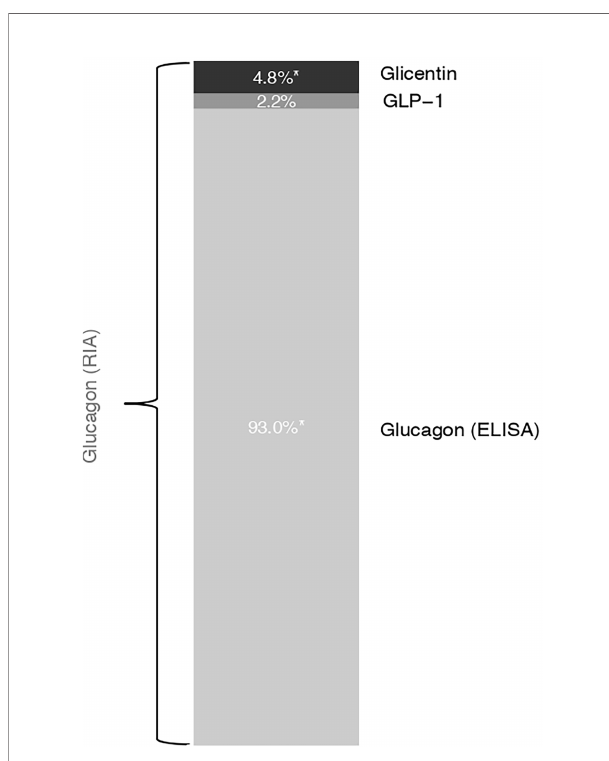
FIGURE 4 | Estimated model-based relative contribution of proglucagon cleavage products to the variance of RIA-derived glucagon measurements. We used linear mixed models with the participant as a random intercept and the OGTT-time point as fi xed effects. Marginal R squared was calculated to describe the proportion of variance in the outcome variable explained by the fi xed effect. Removing each factor separately, we determined the percentage of its respective contribution to RIA-derived glucagon measurements that are presented here as a bar